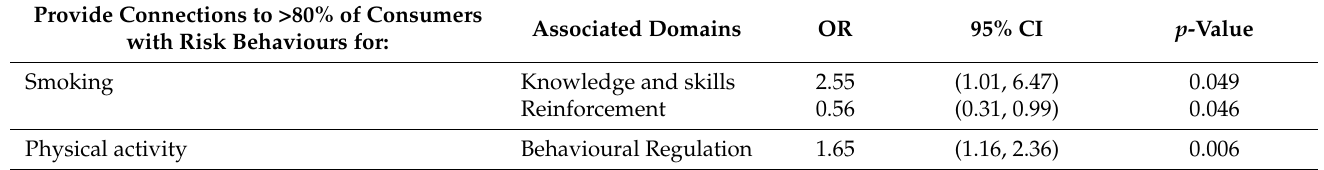
Table 4. Final logistic regression models exploring the associations between TDF domains (13 domains) and the optimal provision of connections for consumers with risk